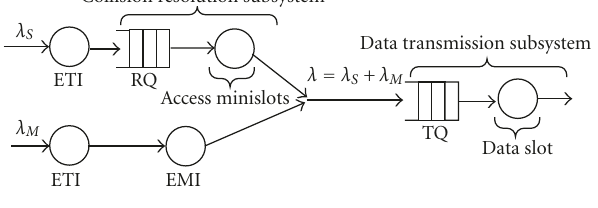
Figure 6: DQMAN Queuing